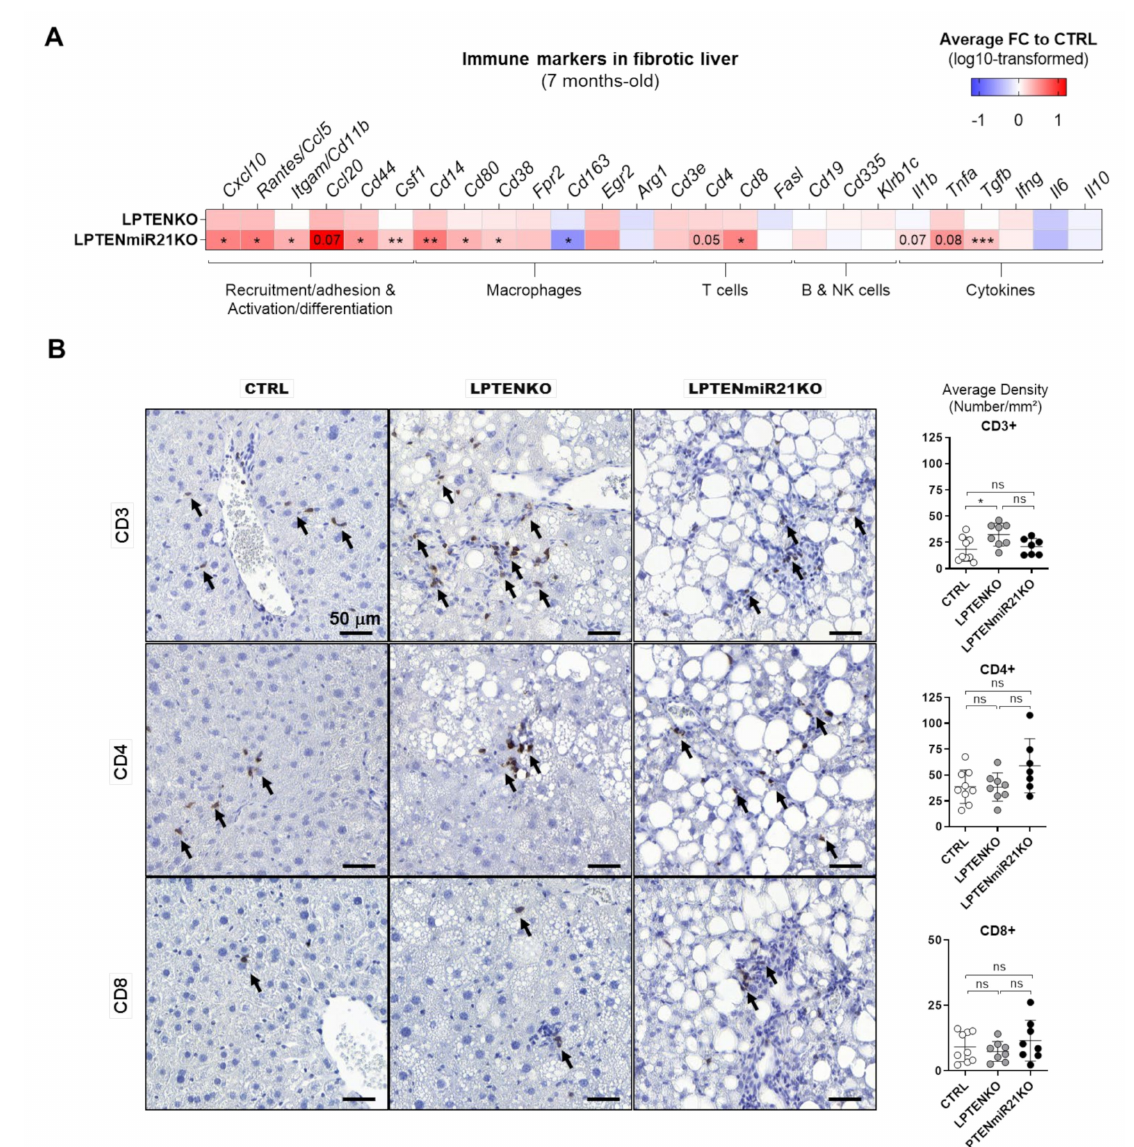
Figure 7. Loss of miR-21 in PTEN-deficient hepatocytes prevents macrophages and increases T-cell recruitment in pre- tumoral hepatic tissues. ( A ) Heatmap representation of relative mRNA expression of inflammatory markers involved in immune cell recruitment, adhesion, activation, and differentiation; of macrophages, T cells, B cells and NK cells; and of pro- and anti-inflammatory cytokines in pre-tumoral hepatic tissues of 7-month-old mice (CTRL, n = 9; LPTENKO, n = 8; LPTENmiR21KO, n = 12). Data were submitted to log10-transformation of the fold-change (FC) to CTRL and is represented as means. ( B ) Representative immunohistochemical staining of CD3, CD4, and CD8 in liver sections (left) and quantification of positive cells (number of positive cells per mm 2 , right) in CTRL ( n = 9), LPTENKO ( n = 8), and LPTENmiR21KO ( n = 7–8) mice. Data is represented as mean ± SD. Data that failed normality tests was submitted to log10-transformation prior to statistical analysis. An outliers test was performed using the ROUT method (Q = 1%). Unpaired t -test with Welch’s correction was used for comparison between two groups. One-way ANOVA with Holm–Sidak’s correction was used for comparison between more than two groups. * p -value < 0.05, ** p -value < 0.01, *** p -value <